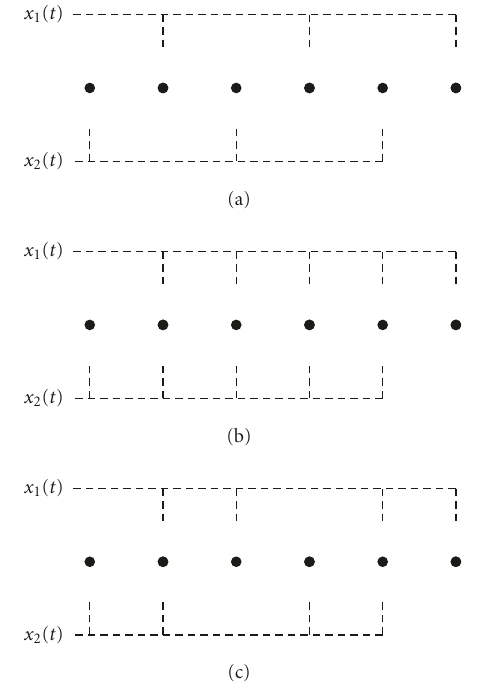
For narrowband signals of centre frequency ω 0 , a time lag can be approximated by a phase rotation, that is, for all δ <